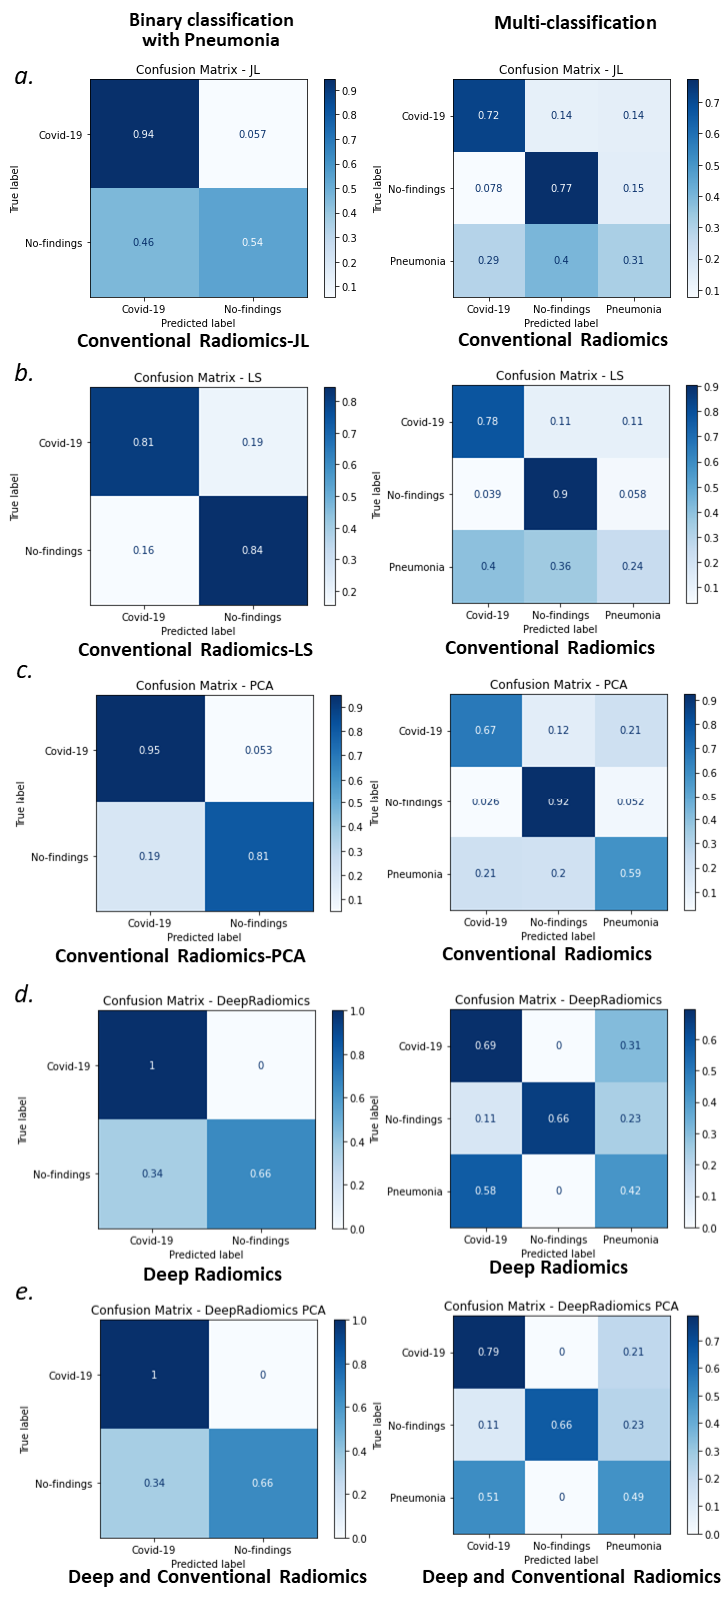
Figure 7. Confusion matrices for binary-class (upper row) and multiclass (lower row) classification of COVID-19 are presented for conventional radiomics ( a – c ); deep radiomics ( d ), and a combination of both groups of radiomics for the best conventional radiomics ( e ).